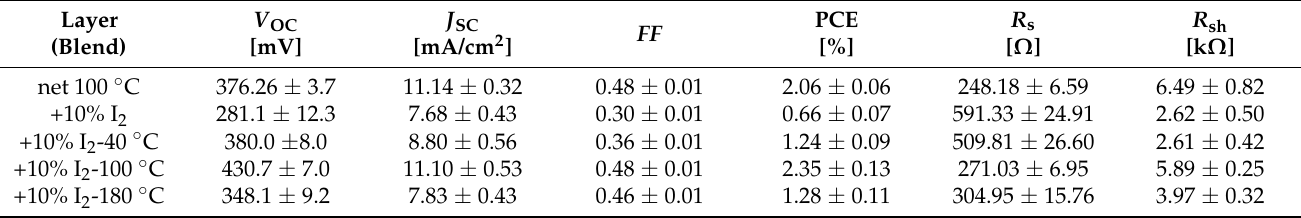
Table 3. Parameters of BHJ devices under